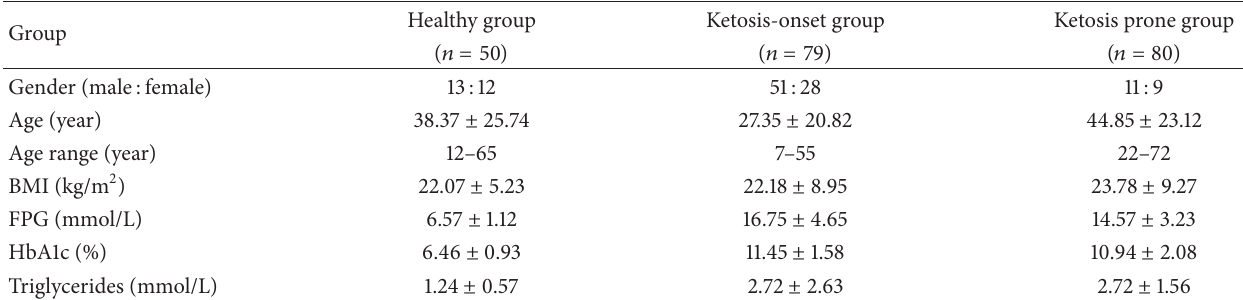
Table 4: Healthy group compared with ketosis-onset and ketosis prone